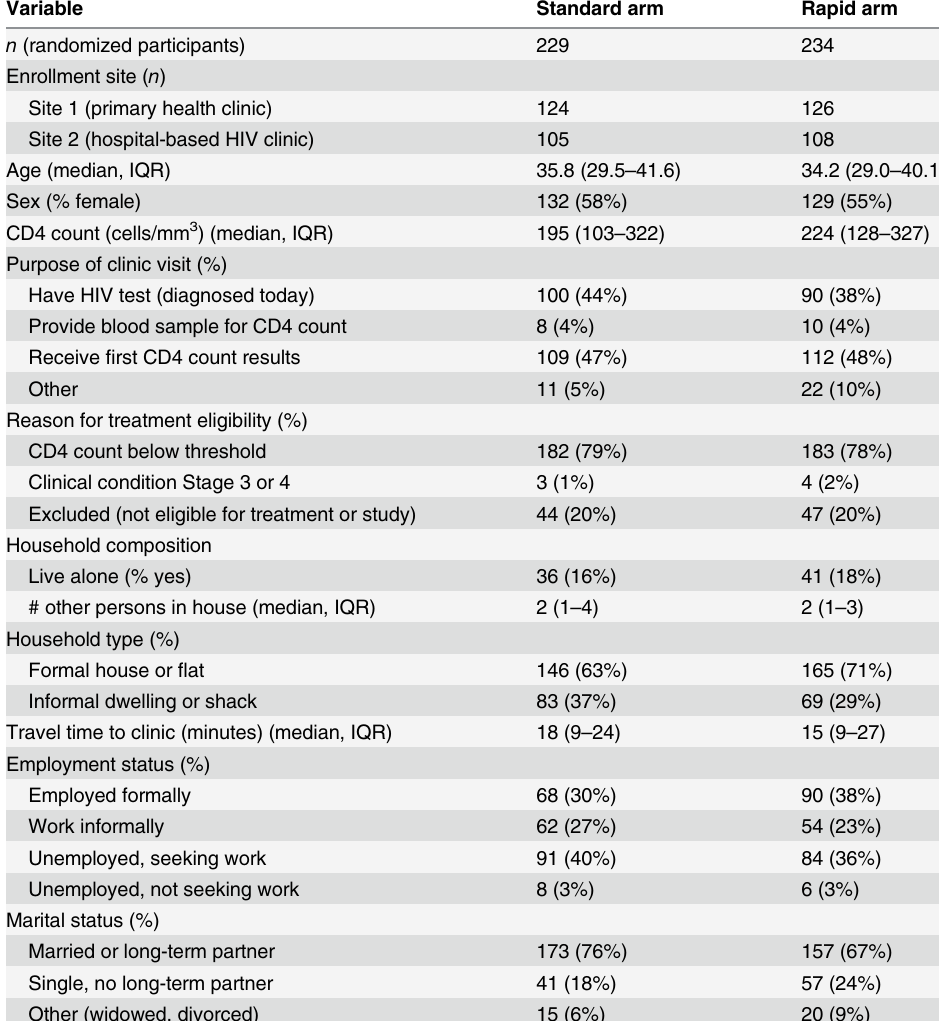
Table 1. Baseline characteristics of study sample ( n =